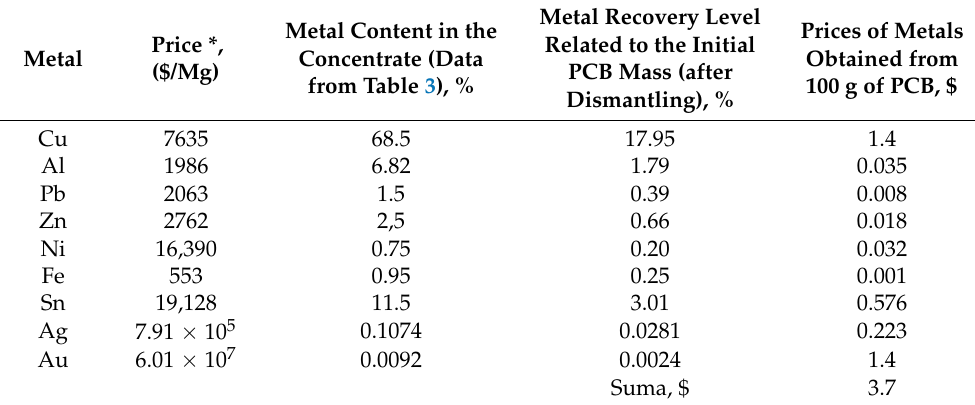
Figure 9. Metal content in the concentrate obtained from electrostatic separation for the option of PCB grinding using cryogenic temperatures and 1 mm screen perforation. Table 6. The value of metals recoverable from the concentrate obtained from electrostatic separation for the option of PCB grinding using cryogenic temperatures and 1 mm screen